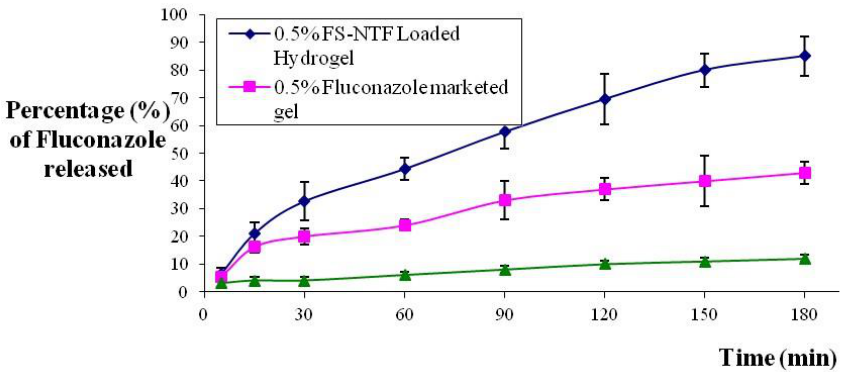
Figure 9. In vitro release profile of fluconazole from aqueous suspension, marketed gel, and HA-FS-NTF formulation. Data are expressed as mean ± SD ( n = 3).